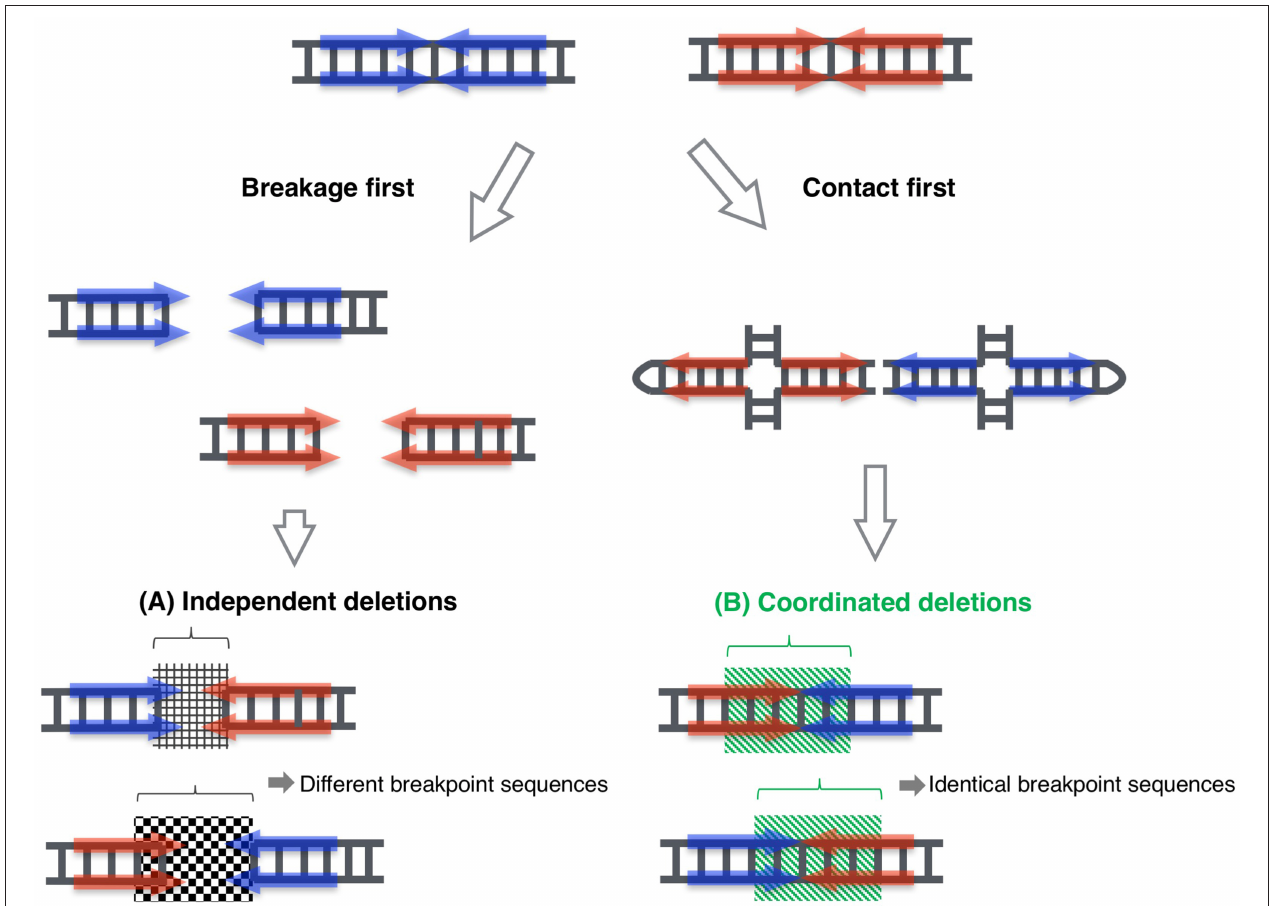
FIGURE 2 | Proposed model for coordinated joining of derivative chromosomes. Two derivative chromosomes have an increased likelihood of having identical junction sequences, indicating that exactly equal-sized deletions occurred in each palindrome center, which then joined to form two junction fragments. This phenomenon cannot be explained by the classical model, where the two double-stranded breakages are processed independently (A) . This could happen when the breakpoints of the derivative chromosomes are generated in a coordinated manner (B) . (Inagaki et al., 2013; Mishra et al., 2014).